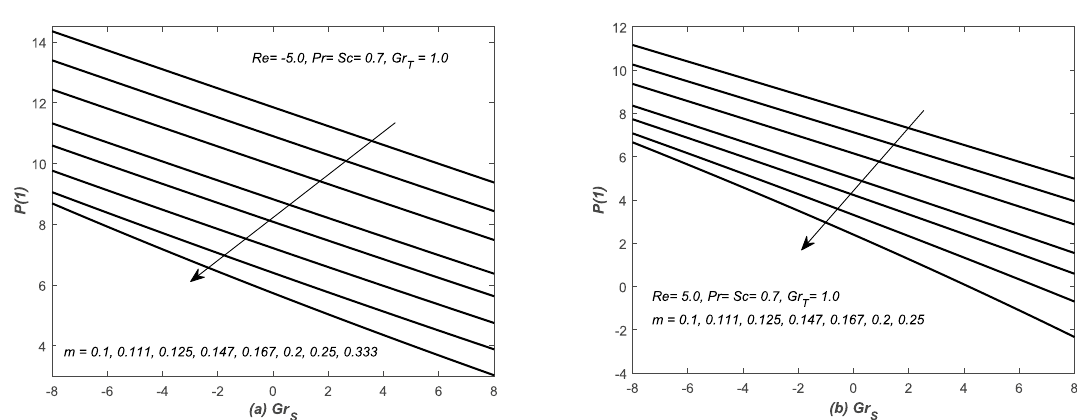
Figure 3. The dimensionless pressure at wall i.e. P (1) is plotted against the Reynolds number Re , whereas, assisting and opposing flows of air are taken in inclined for different values of slope m .